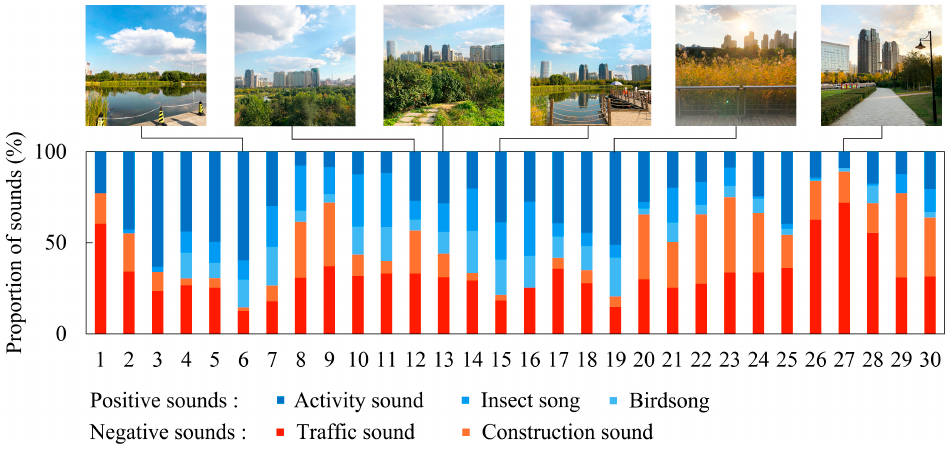
Figure 3. The proportion of sounds in each survey point and photographs in typical survey points in Cloves